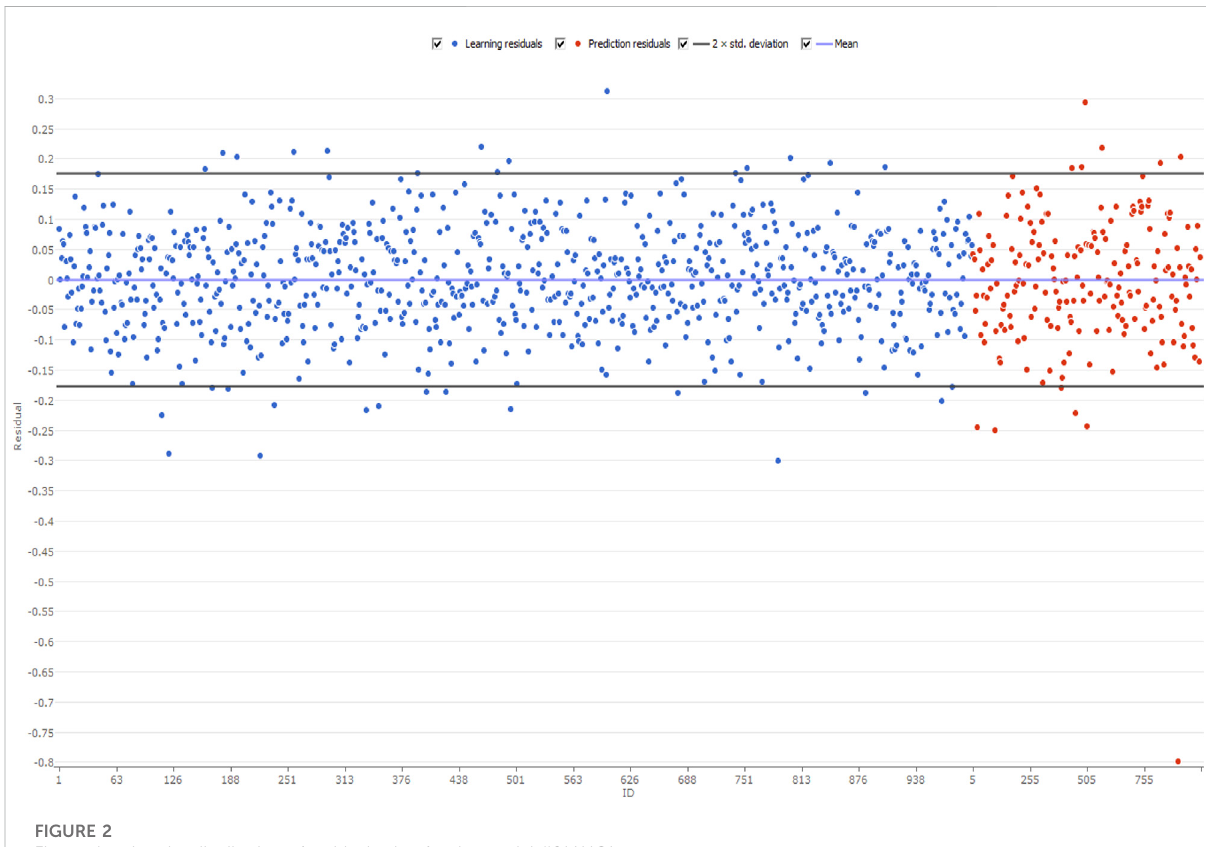
FIGURE 2 Figure showing the distribution of residual value for the model #21ANG1.